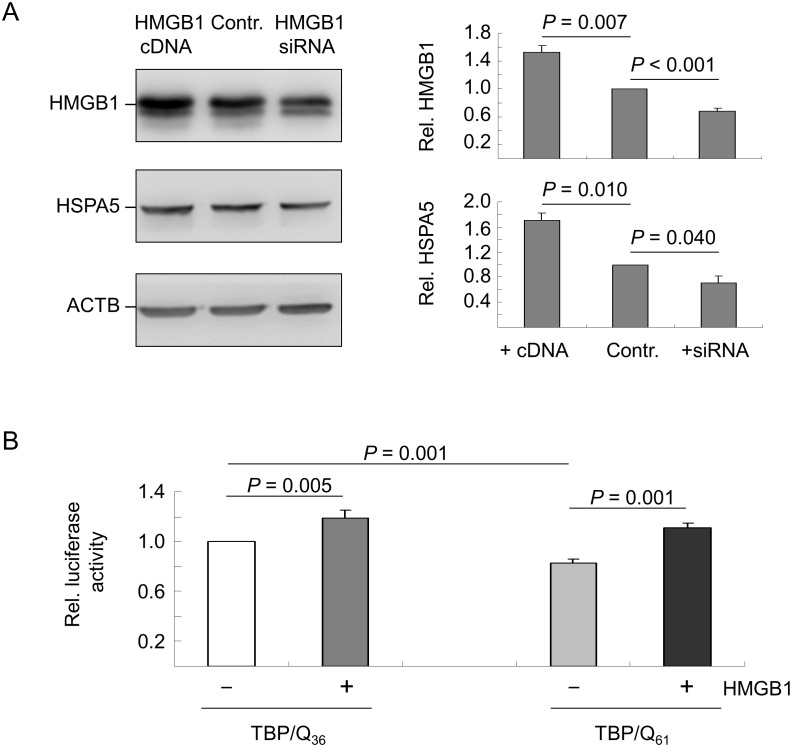
HMGB1 modulation of HSPA5 gene transcription.(A) HEK-293T cells were transiently transfected with HMGB1 cDNA or siRNA. After 2 days, the cell lysates were prepared and analyzed using anti-HMGB1 and anti-HSPA5 antibodies. The HMGB1 and HSPA5 protein levels were normalized to the loading control, β-actin (ACTB). The levels of HMGB1 and HSPA5 proteins in the vector-transfected cells (Contr.) were set to 100%. The data are expressed as the mean ± SD values from three independent experiments. (B) 293-derived TBP/Q36∼61 cells were induced for 2 days to express TBP. The HSPA5 luciferase reporter and pcDNA3 without (–) or with (+) HMGB1 cDNA were then transiently expressed for an additional 2 days. The levels of luciferase activity were expressed as fold change compared with the activity of the HSPA5 reporter in cells expressing TBP/Q36. Each value represents the mean ± SD of three independent experiments; each experiment was performed in duplicate.